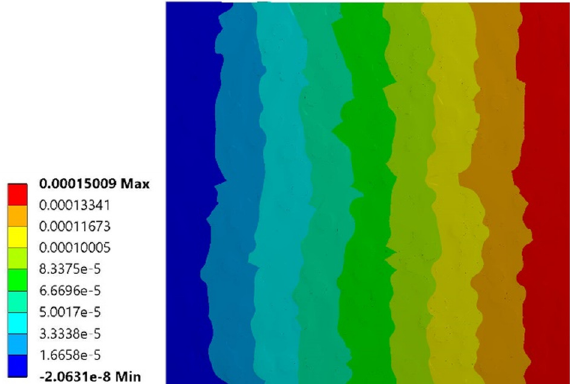
Figure 5. Results of the numerical simulation of simple tensile loading in the x direction for an epoxy short sisal fiber composite with V f = 0.35. Map of displacements in x -direction (numerical values represent displacements in meters).